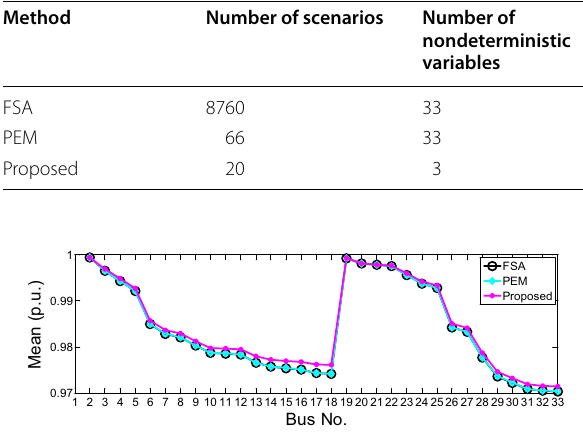
Fig. 7 Mean value of the elements in bus voltage profiles